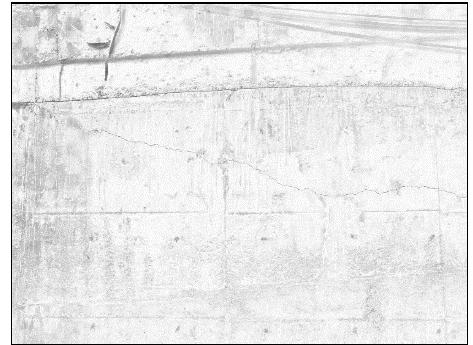
Figure 12. The result after background subtract